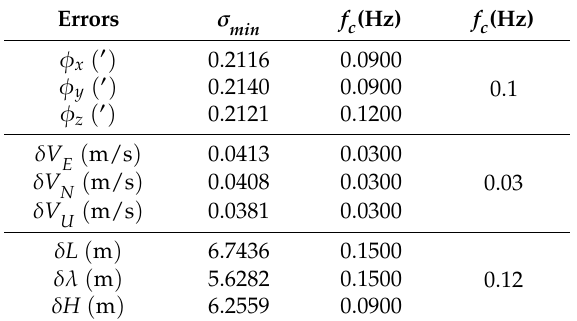
Table 1. Statistics of minimum standard deviations and corresponding cut-o ff